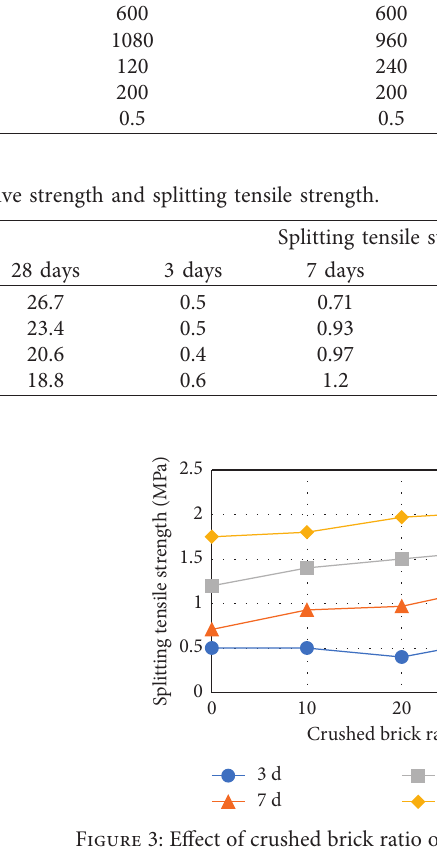
Figure 2: Effect of crushed brick ratio on compressive strength of concrete.